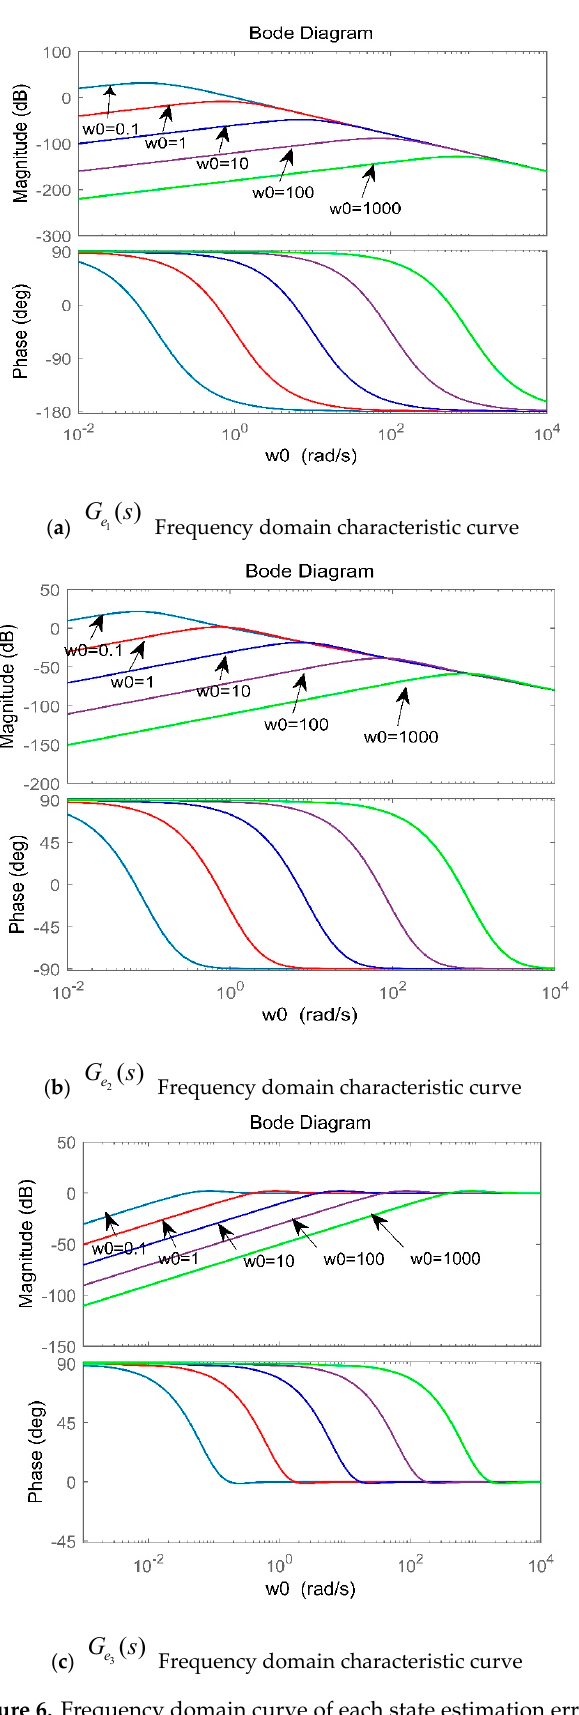
Figure 6. Frequency domain curve of each state estimation error.